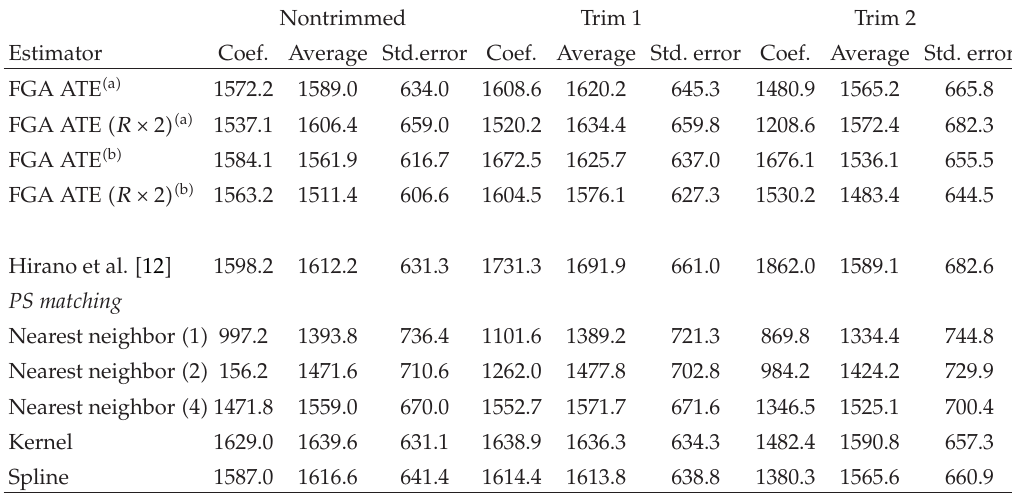
Table 3: ATE estimators of the e ff ect of training on earnings. Nontrimmed Trim 1 Trim